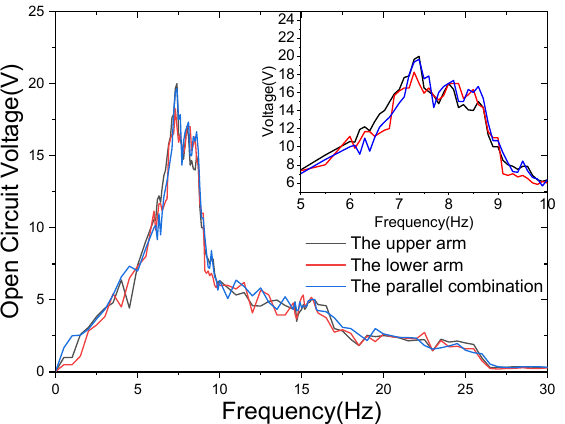
Figure 8. Tuning fork upper arm, lower arm, and double arm parallel sweep voltage, under an acceleration of 0.7 g, with impact spacing of 1.5 cm.